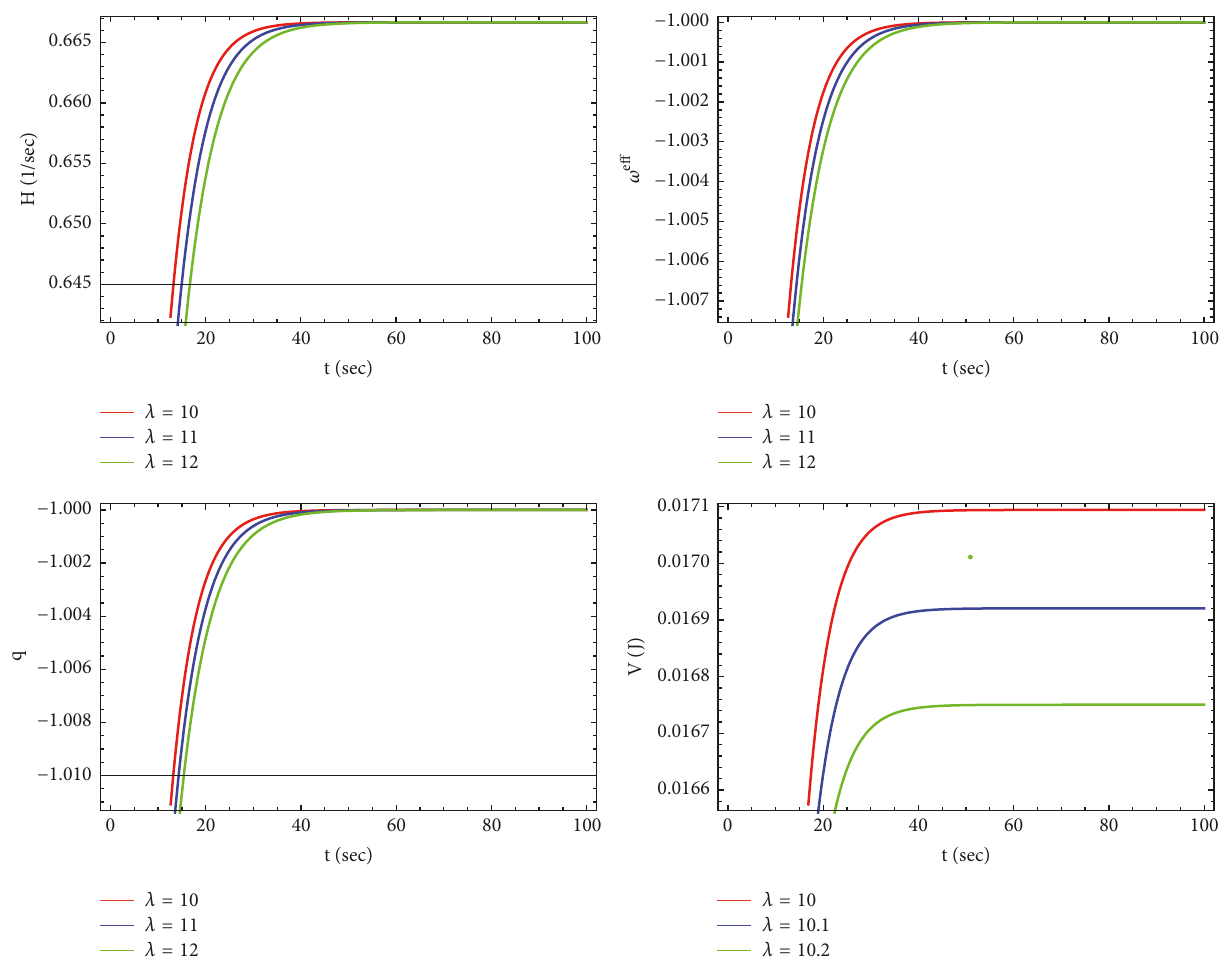
Figure 8: Plots of 𝐻 , 𝜔 𝑒𝑓𝑓 , 𝑞 , and 𝑉 versus 𝑡 for 𝑊(𝜑 − ) = 𝑏 2 ((𝜑 − ) 2 /3 − 𝜑 − ) , 𝑏 2 = −1(1/𝑠𝑒𝑐) , and 𝜑 − (0) = 0.1 when 𝑘 = −1